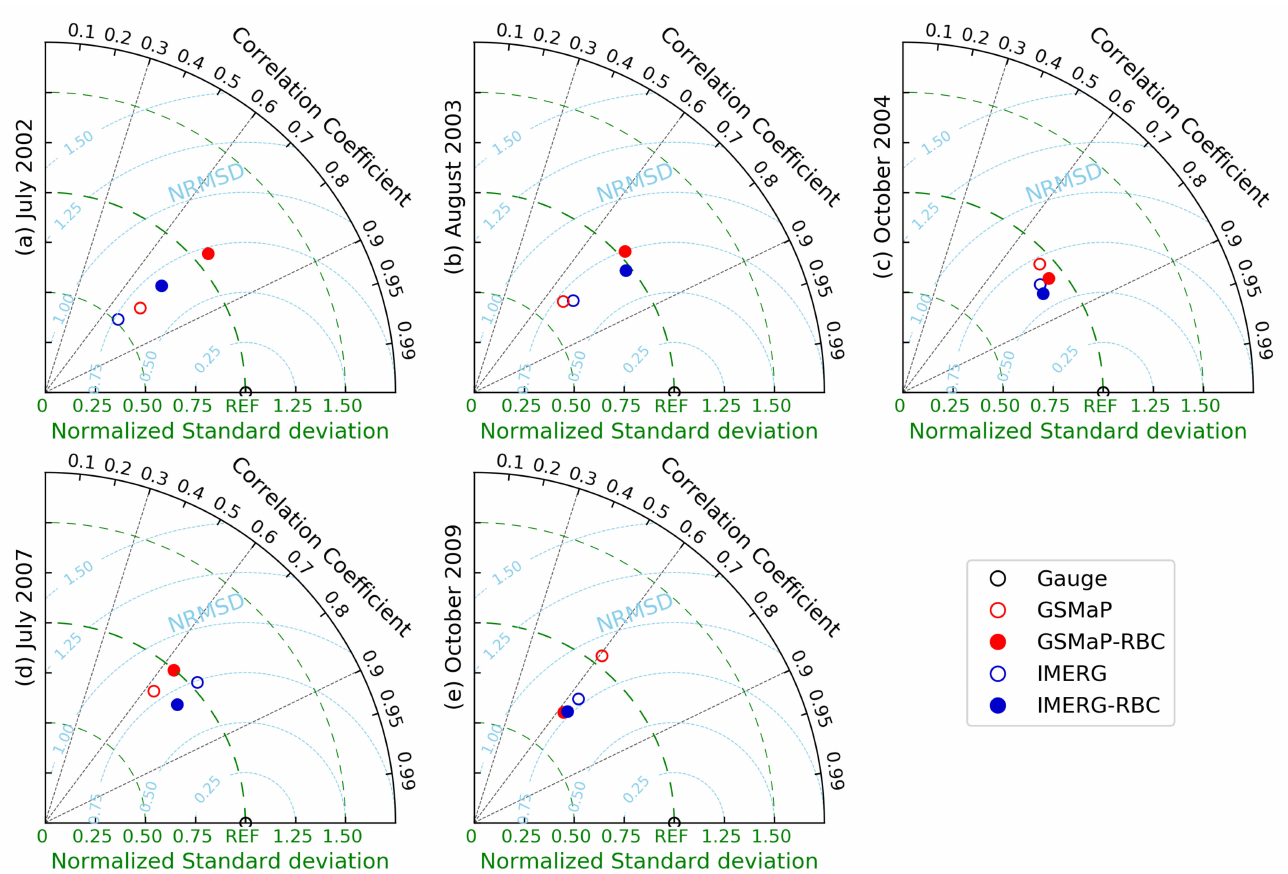
Figure 5. Taylor diagram for the original and best-corrected SPPs of five flood cases. ( a )–( e ) represent five cases